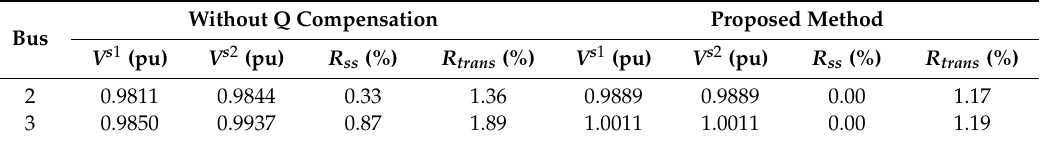
Table 7. Comparison of voltage variations in Case 3.